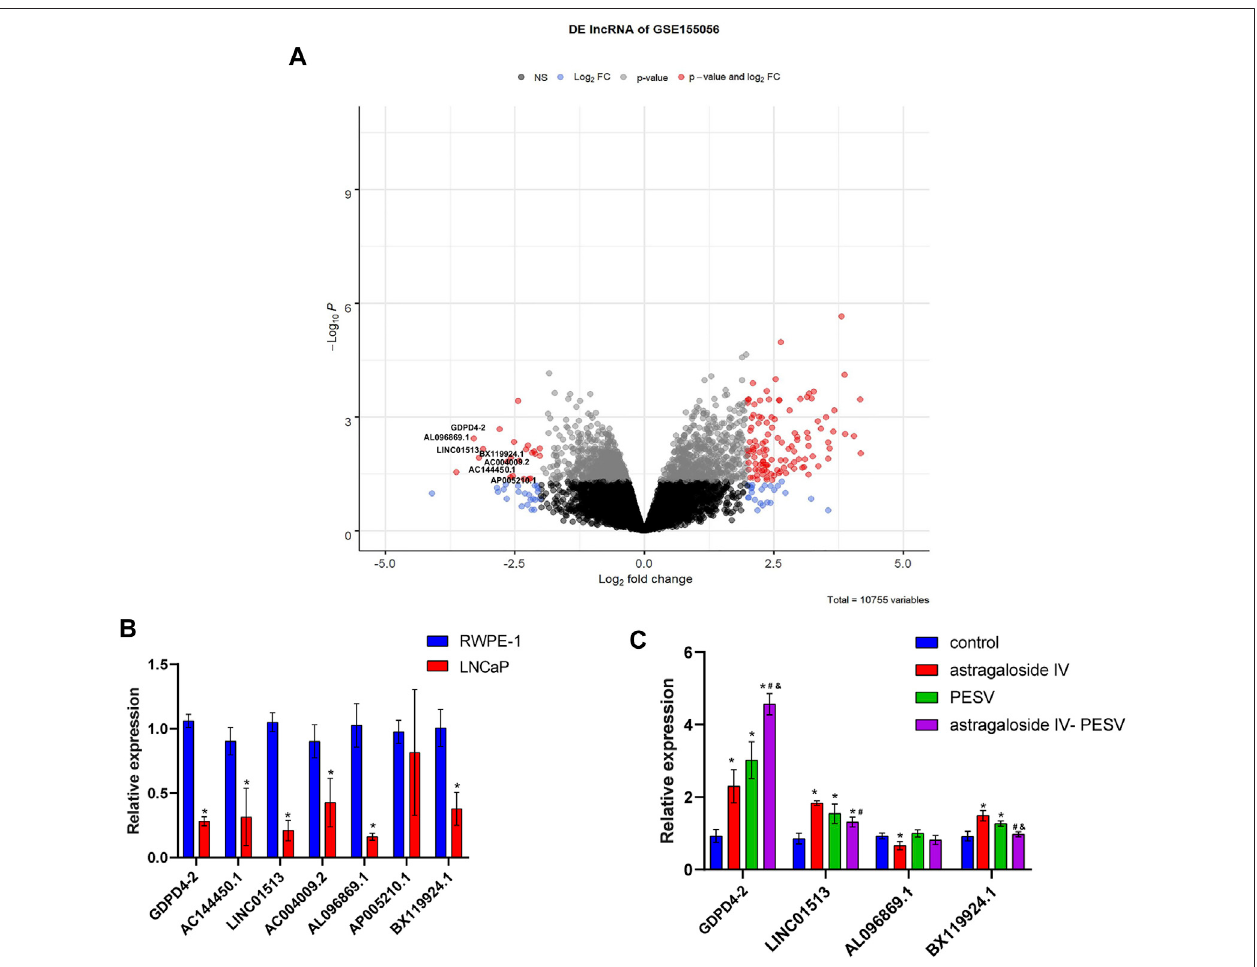
FIGURE4| GDPD4-2wasup-regulatedinPCatissuesandcells,whichwasrelatedtothetreatmentofherbpairAstragalusIV-PESV. (A) VolcanoplotshowedthelncRNA expression. (B) ThedifferentiallncRNAexpressioninRWPE-1andLNCaPcells,* p < 0.05vs.RWPE-1group. (C) ThedifferentiallncRNAexpressionwasanalyzedbyRT-qPCRin LNCaP cells after treatment with Astragaloside IV-PESV. * p < 0.05 vs. control group, # p < 0.05 vs. Astragaloside IV group, & p < 0.05 vs. PESV group.